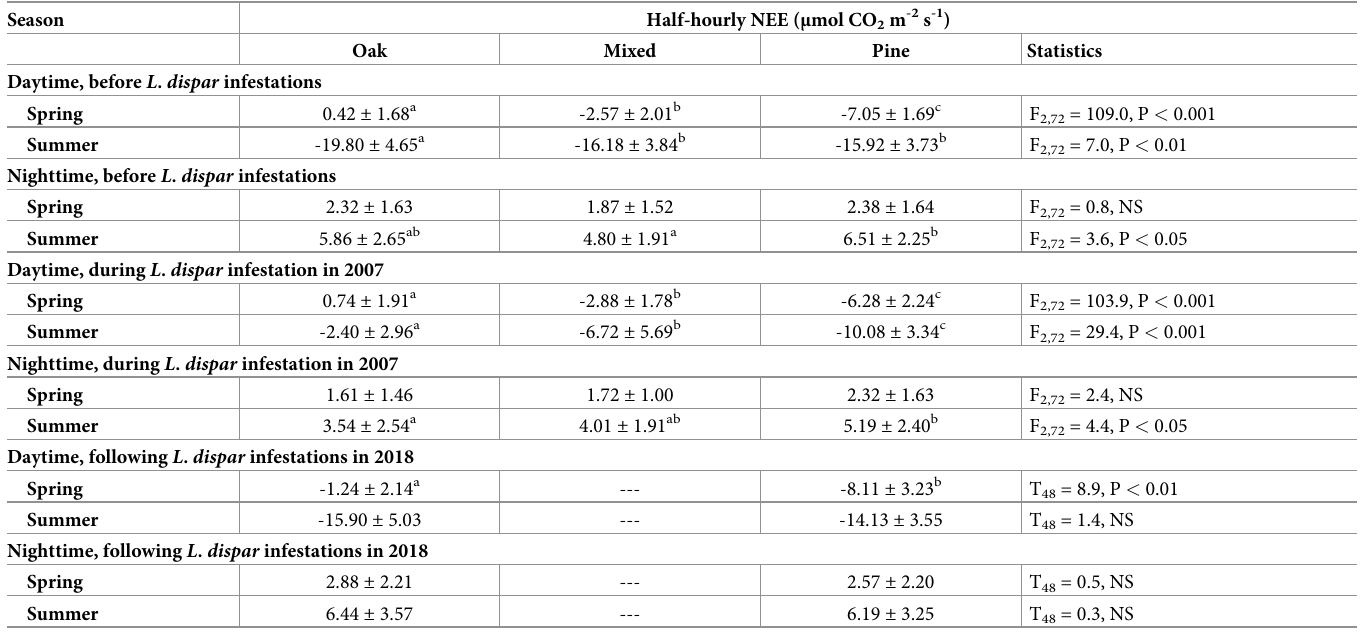
Table 3. Half-hourly net CO 2 exchange (NEE) during spring (April 1 to May 15) and summer (June 1 to August 31) months at the oak, mixed and pine stands.